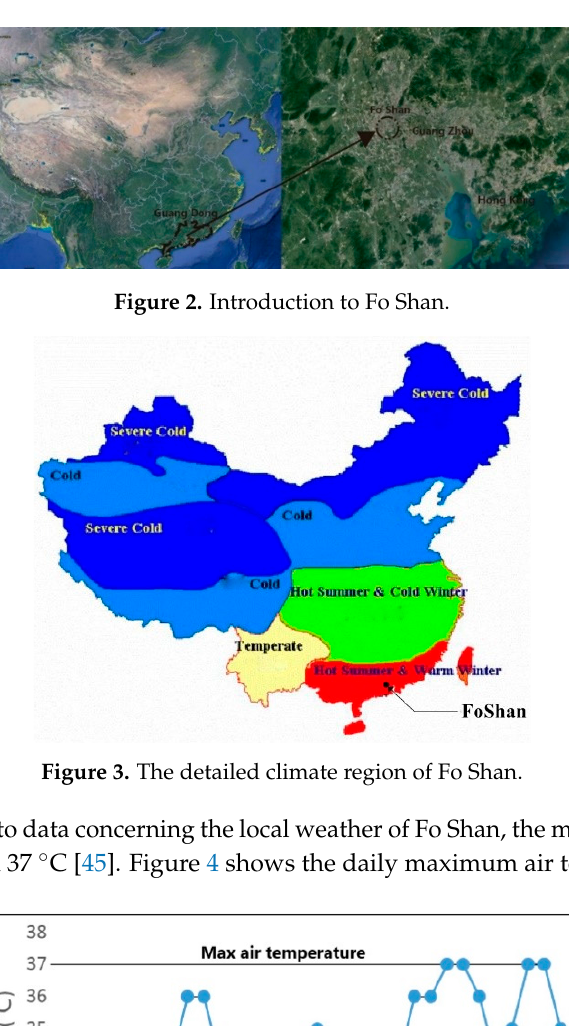
Figure 4. Daily air temperature in July 2016.